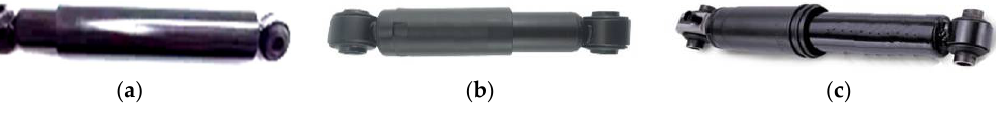
Figure 6. The selected dampers: ( a ) #1; ( b ) #2; and ( c ) #3.